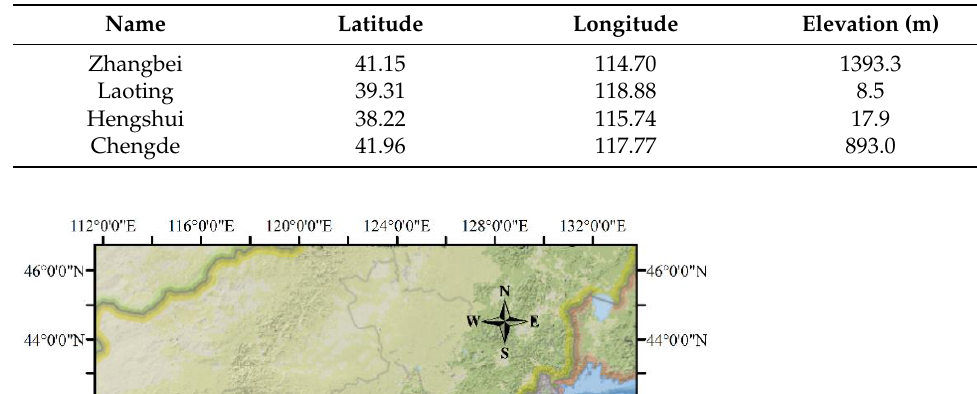
Table 2. Geographic information of the ground radiation stations.